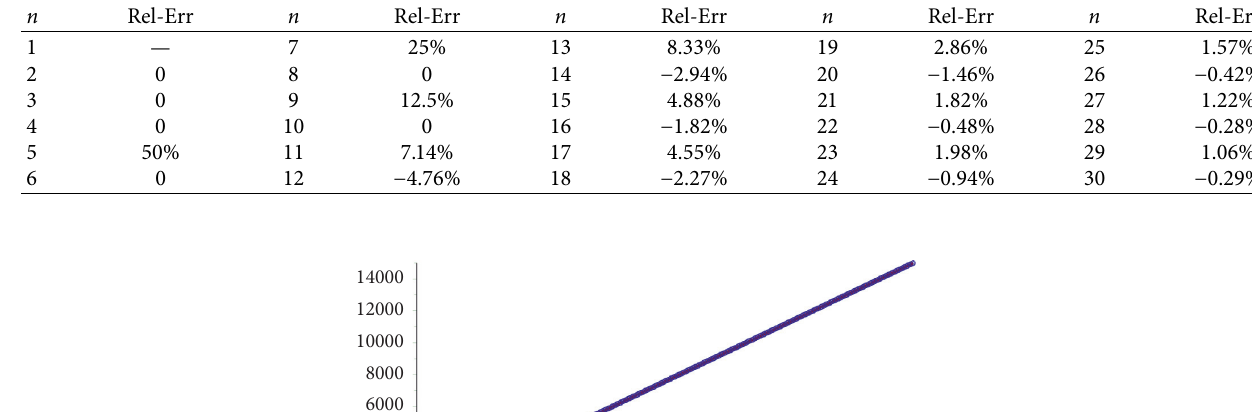
( n ) + 1/2 􏽪 􏽫 to h ( n ) when n ⩽ 30. g 1